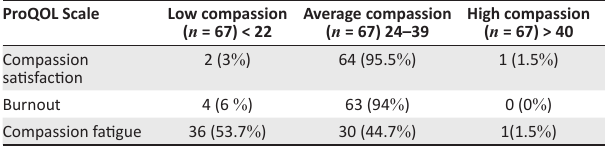
TABLE 2: ProQOL ( n = 67) demonstrating low or average and high level scores attained by